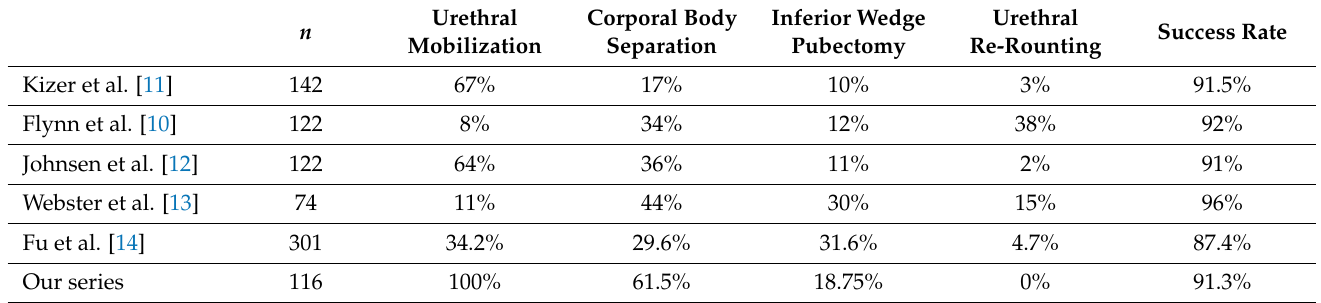
Table 2. Percentage of cases using the different steps of the elaborated perineal posterior urethroplasty by